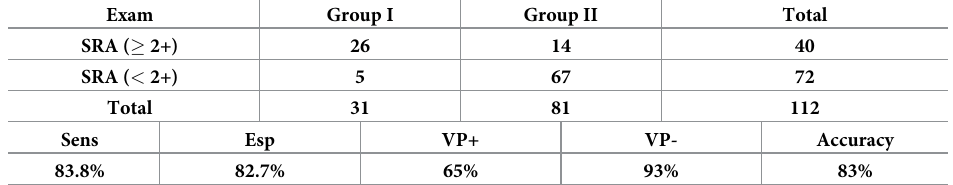
Table 5. Total number of patients with two or more positive SRA results (Risk 1) in Groups I and II in the three hours preceding POAF (Group I) or three hours of recording on the second postoperative day (Group